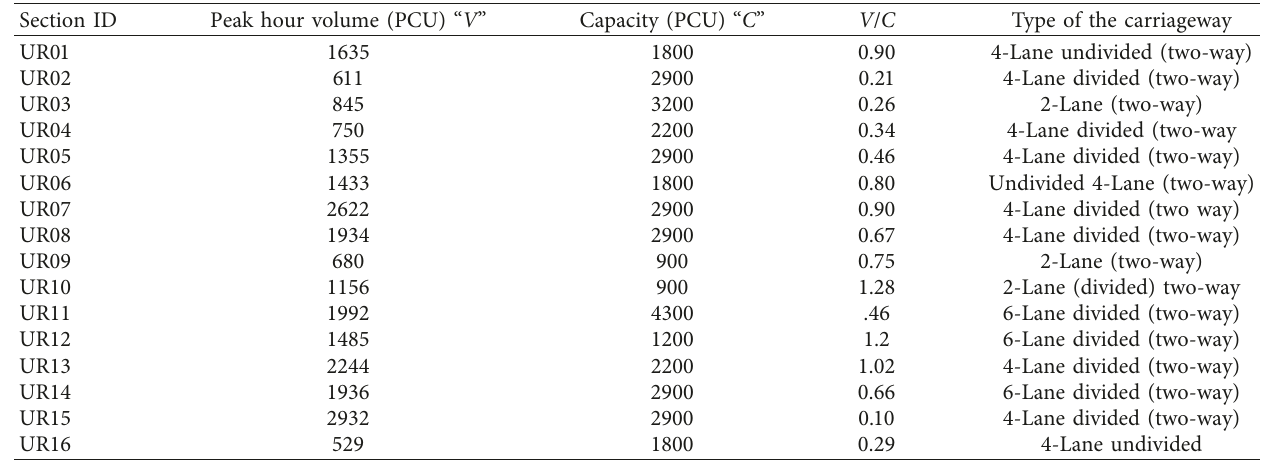
Table 3: Volume-to-capacity ratio of selected road